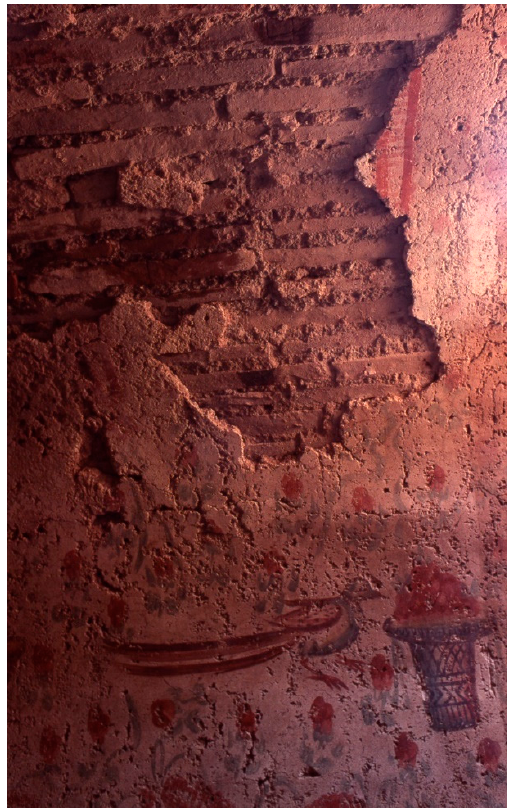
Figure A10. Sardis, Tomb 79.2 (Appendix A.6), detail of east wall. © Archaeological Exploration of Sardis/President and fellows of Harvard College.